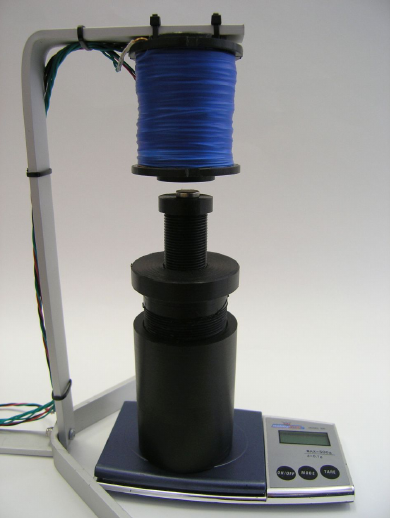
Figure 4. Experimental determination of the magnetic force.